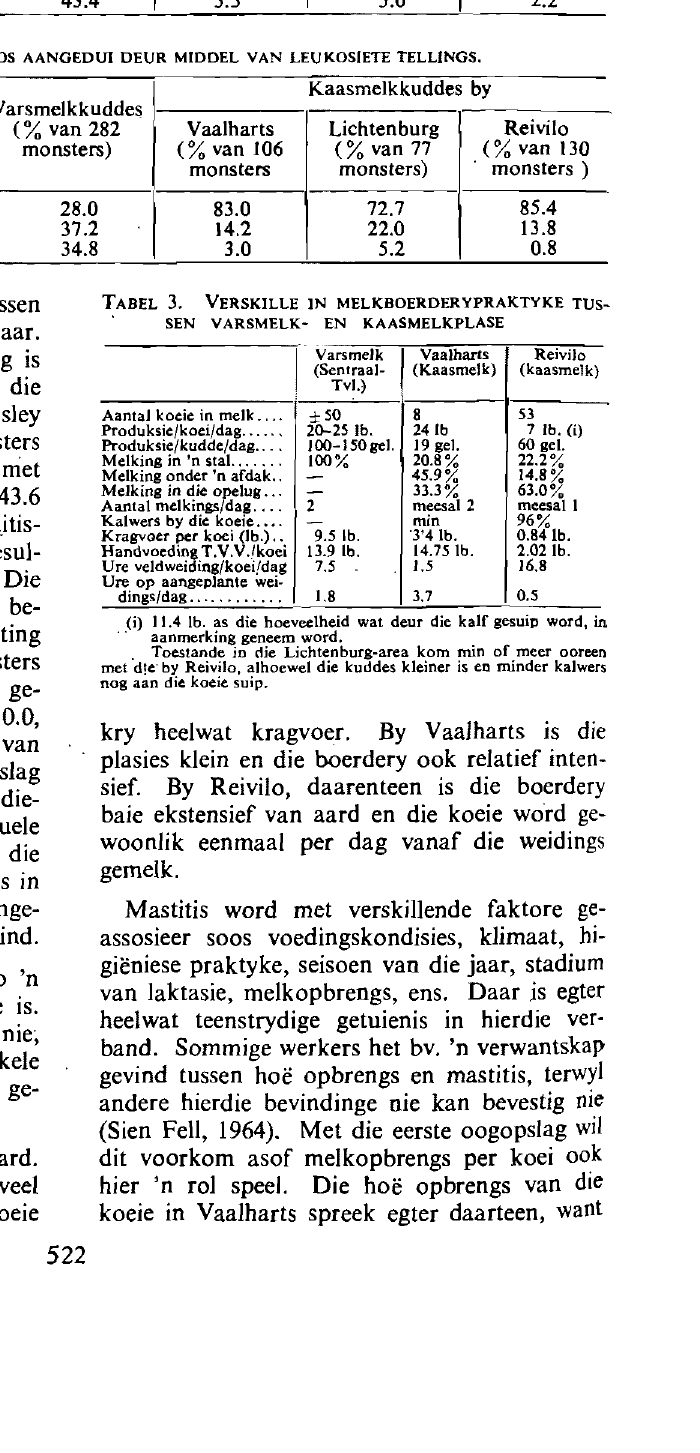
TABEL 1.-MASTITIs-vOORKOMS IN MELKKUDDES, SOOS AANGEDUI DEUR MIDDEL VAN C.M.T.-TOETSE.